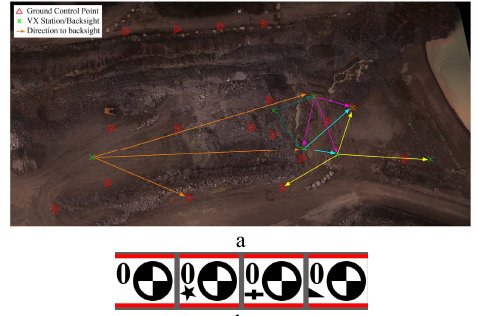
Figure 4. The test-fields for a) camera calibration, b) platform calibration